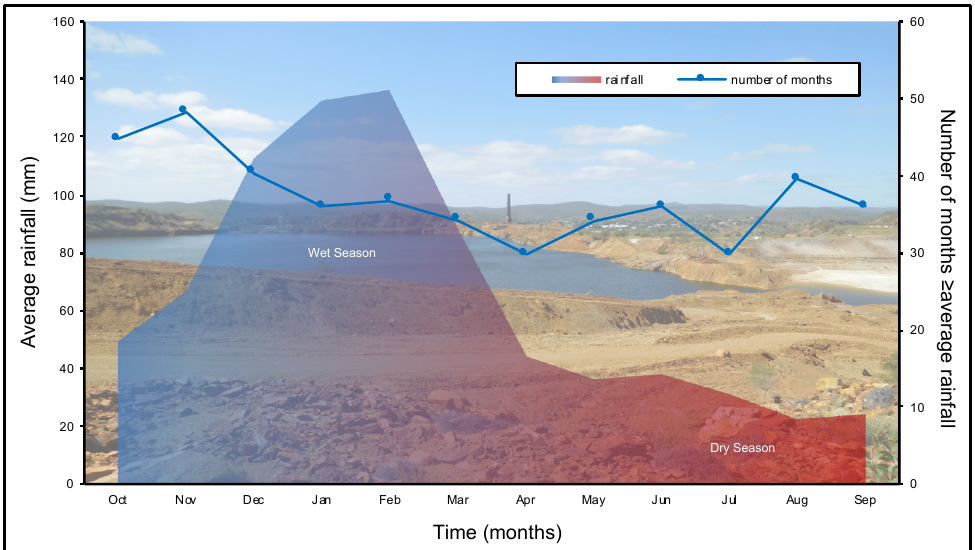
Figure 10. A plot of average monthly rainfall and the number of respective months with rainfall equal to or greater than the monthly average from 1901 to 2015. The environmental conditions of the wet and dry season highlight the chemical reaction that would likely be dominant. However, it is important to note that these reactions can occur contemporaneously as well as throughout the year. Data was obtained at Moonmera Station (#039067, 23.58 ◦ S 150.40 ◦ E) by The Bureau of Meteorology, Australian Government and is publicly available